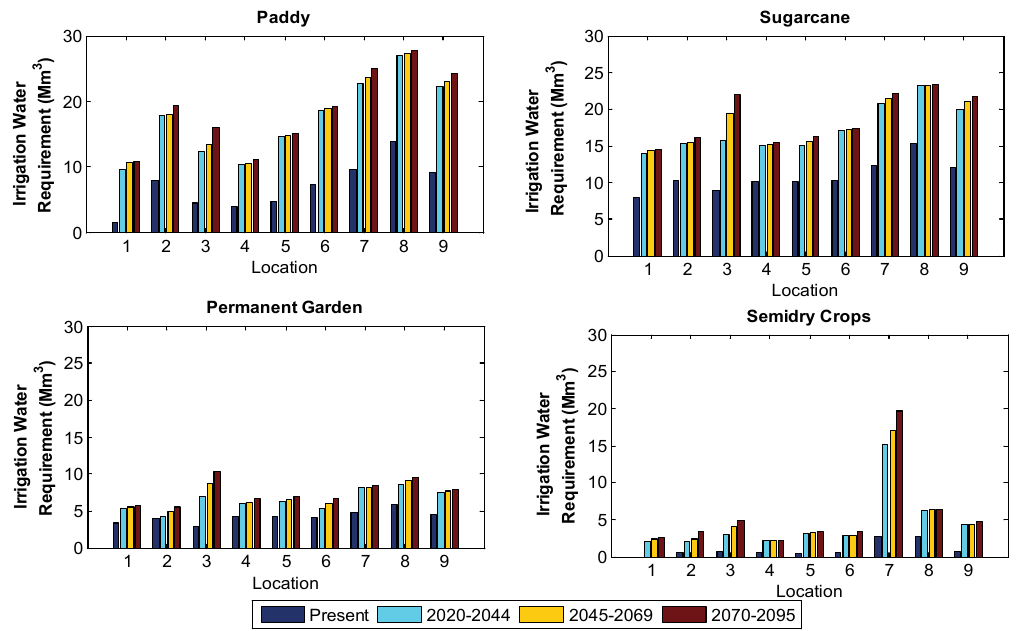
Fig. 3 Historical and projected irrigation water requirements for the Bhadra command area (source: Rehana and Mujumdar